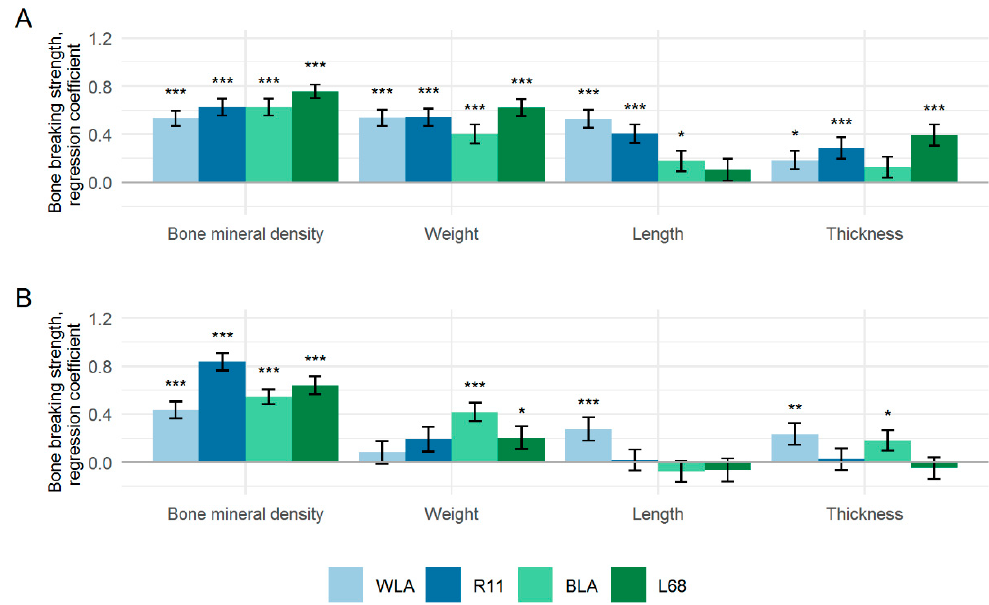
Figure 3. Standardised regression coefficients ( β ) ± standard errors of regression of bone mineral density, bone weight, bone length and bone thickness pertaining univariately to the bone breaking strengths of the tibiotarsus ( A ) and humerus ( B ) in four different chicken layer lines (WLA, R11, BLA, L68). Significant regression coefficients are marked with asterisks (* p < 0.05; ** p < 0.01; *** p < 0.001).